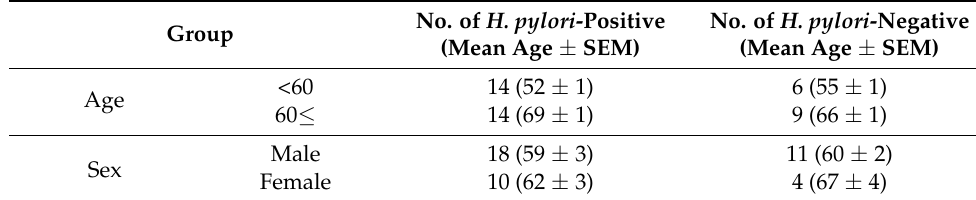
Table 2. Summary of patients’ information. Group